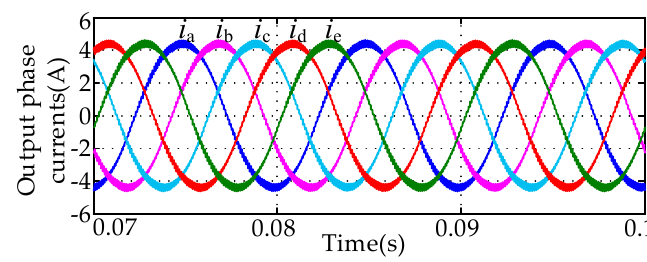
Figure 9. Five-phase output currents.